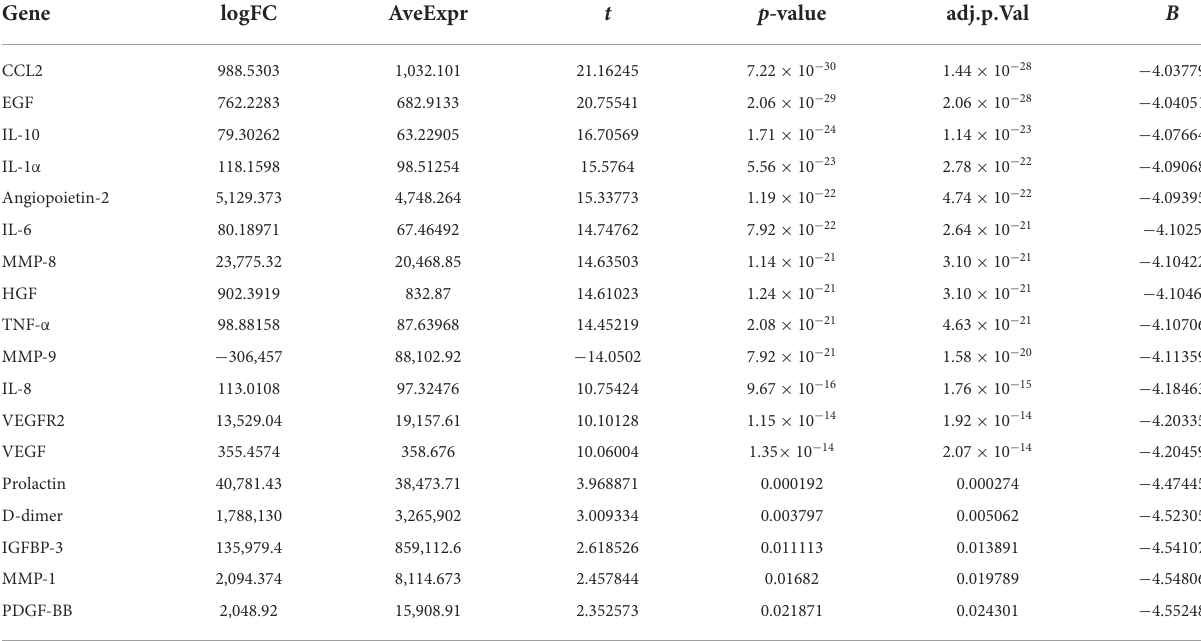
TABLE 3 Differential expression of all cytokines in peripheral blood samples between the postoperative CSDH and normal groups. Gene logFC AveExpr p -value